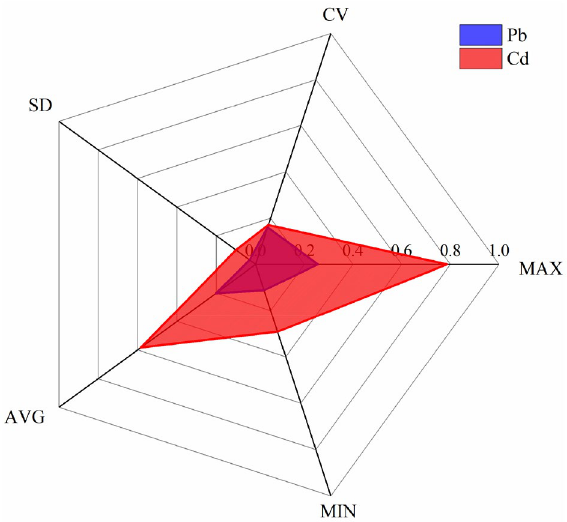
Figure 8. Analysis results of activation rate of lead and cadmium in soil.